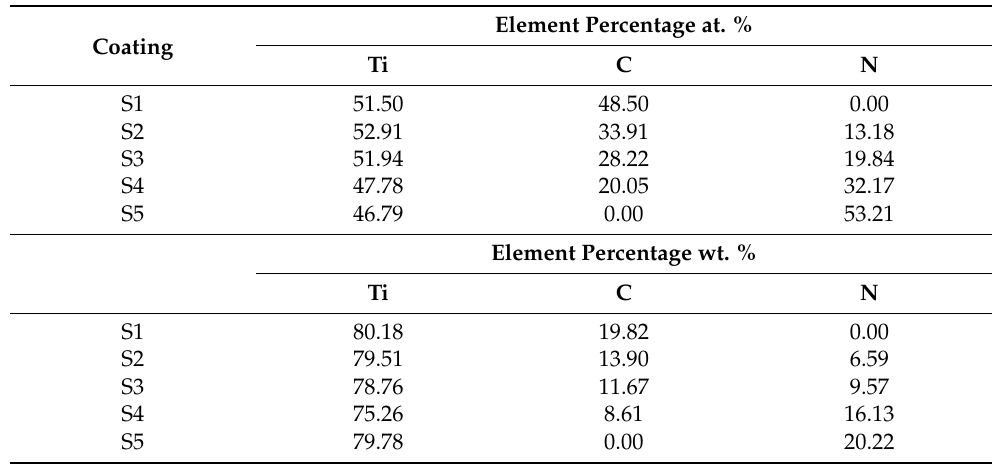
Table 2. Chemical composition of tested